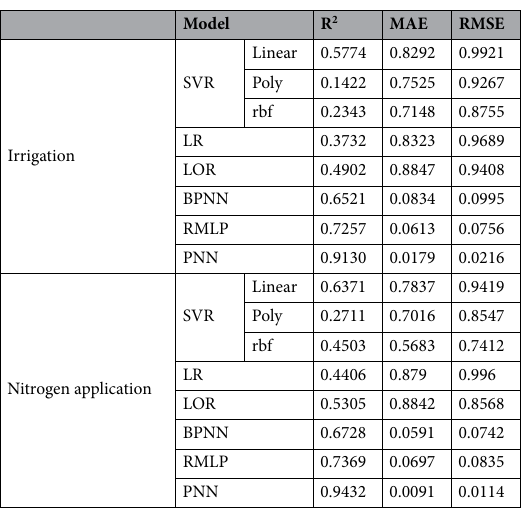
Table 10. Model performance parameters.